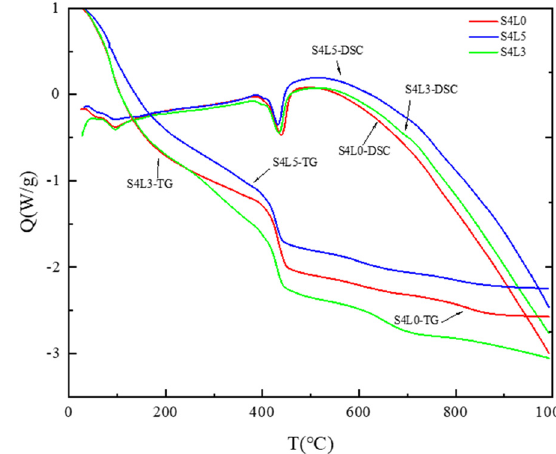
Figure 7: Experimental results of viscosity change with time.